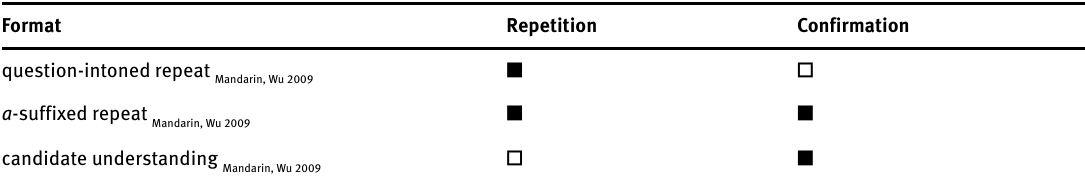
Table 4: Three restricted repair initiation formats identified in Mandarin Chinese conversations (Wu 2009) and their analysis in terms of two properties of repair initiators.